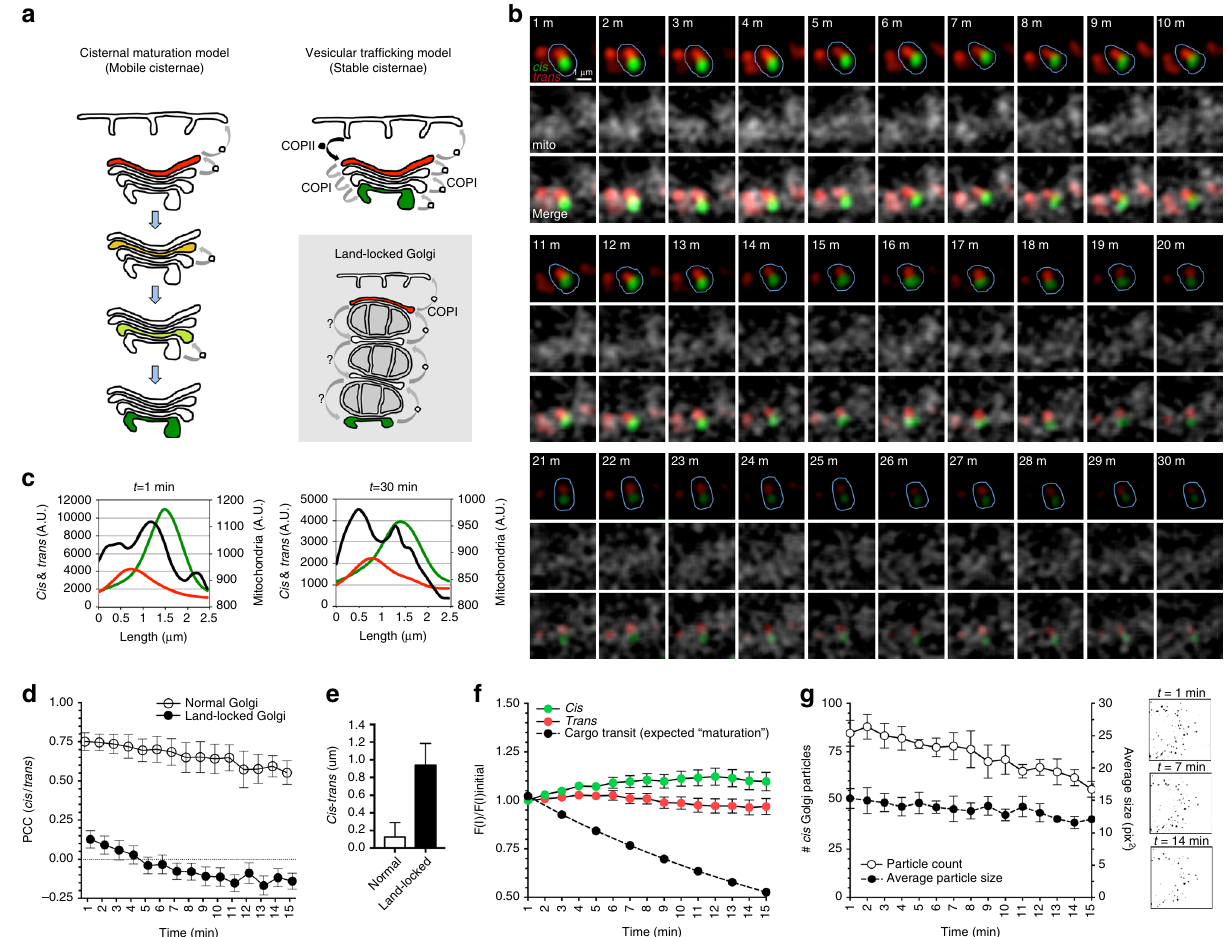
Fig. 6 Land-locked cisternae are stable and do not mature. a Cartoons showing the two main intra-Golgi traf fi cking models and the land-locked Golgi. The cisternal maturation model postulates that the cisternae are mobile, maturing from cis to medial to trans as they progress through the stack. These mobile cisternae serve as anterograde cargo carriers, processing the cargo within as they uptake resident enzymes from older cisterna by retrograde COPI vesicles. The stable compartments model postulates that the Golgi exists as a static compartment that receives and exports cargo through anterograde COPI-coated vesicles. Cisternal identity is preserved by the recycling of any leaked enzymes in retrograde COPI vesicles. In land-locked Golgi, the cisterna are separated and adhered to mitochondria, increasing the spatial separation between cisternae from ~30 to ~500 nm. While a role for recycling Golgi enzymes by retrograde COPI vesicles is established, the question mark denotes how it is unclear what mediates anterograde traf fi c. b Live imaging land-locked Golgi. HeLa cells were transfected with GRASP55-FKBP-BFP and FRB-Myc-Omp25 to be able to re-target Golgi to the mitochondria, as well as GRASP65-GFP to mark the cis- Golgi and GalT-RFP to mark the trans- Golgi. Cells were treated with nocodazole to break the Golgi ribbon into mini-stacks, and then with dimerizer to produce land-locked Golgi. Then the cells were imaged every minute as a z-stack for 30 min. A single confocal section of a land-locked Golgi whose cis- Golgi and trans- Golgi markers fl ank a mitochondria is followed over time (encircled in blue ). c Plot pro fi les were taken across land-locked Golgi shown in b for cis- Golgi (GRASP65-GFP, green ), trans- Golgi (GalT-RFP, red line ), and mitochondria (GRASP55-FKBP-BFP, black line ) fl uorescence. Cis and trans- Golgi markers remain well separated at t = 1 min and t = 30 min. d PCC was calculated for GRASP65-GFP and GalT-RFP for normal Golgi ( n = 7) and land-locked Golgi ( n = 20) over the course of 15 min on merged planes. Error bars = s.e.m. e Quanti fi cation of the mean distance between the peak fl uorescence of cis and trans- Golgi markers for normal Golgi ( n = 7) and land-locked Golgi ( n = 20). Error bars = s.d. f Quanti fi cation of the integrated intensity of cis and trans -Golgi markers for land-locked Golgi over time (merged planes, n = 20). The inversed rate of hGH arrival at the trans -Golgi (Fig. 5e) is plotted for comparison (expected rate of maturation). Error bars = s.e.m. g Quanti fi cation of the average number (left y -axis, triangles ) and area (right y -axis, circles ) of cis -Golgi particles on merged planes from different cells and experiments ( n = 3). Inset : visual correlates for thresholded cis Golgi-marker positive particles tracked at t = 1, 7, and 14 min. Error bars = the Golgi markers, as we observed very low or negative Pearson ’ s maturation ( trans -Golgi localization of Furin was established in values when immunostaining for endogenous Golgi markers 56 . Supplementary Fig. 2a, b). As the cisternal maturation model The distance between the cis and trans- Golgi markers averaged predicts, the cis -Golgi cisternae should convert into later cisternae 0.13 μ m ( n = 7, Fig. 6e). by acquiring their composition over time, and hence we would Next, we quanti fi ed the integrated intensity of GalT-RFP have expected a signi fi cant reduction in the intensity of either and GRASP65-GFP for the 20 examples of landlocked cis and marker over time should maturation occur. In fact, for the trans -Golgi cisternae for 15 min (Fig. 6f, Supplementary Fig. 11), 20 pairs of land-locked cis and trans -cisternae that we tracked, and plotted the inversed rate of cargo arrival at the trans -Golgi neither of the markers ever deviated more than 10% off the initial from our bulk secretion assay (Fig. 5e) as the expected rate of measured intensity (Fig. 6f, Supplementary Fig. 11). Another